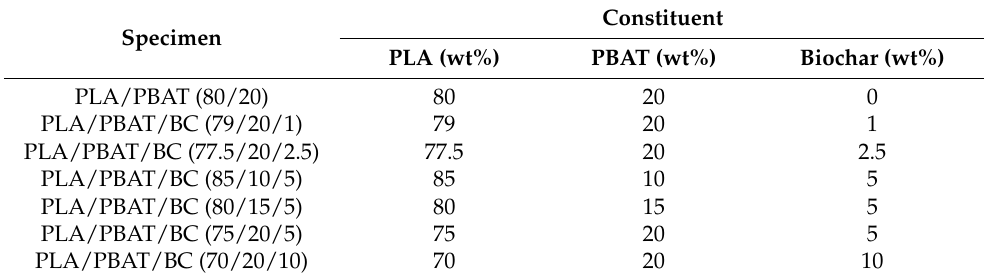
Table 1. Composition details of the polymer